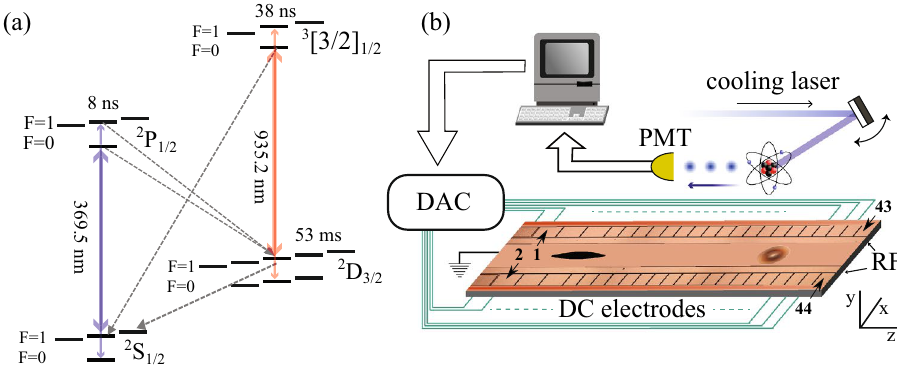
Figure 1. ( a ) Transitions for laser cooling 171 Yb + . The ion is laser cooled on the nearly closed 369.5 nm 2 S 1 / 2 , F = 1 to 2 P 1 / 2 , F = 0 transition. The small amount of off-resonant scattering into the 2 S 1 / 2 F = 0 state is repumped with a 14.7 GHz sideband on the primary cooling laser. Decays from 2 P 1 / 2 can also populate the 2 D 3 / 2 level, which are repumped using a 935 nm laser. ( b ) Schematics of the ion trap chip and the optimization devices. RF and DC electrodes are used to trap the ion and shuttle it above the diffracting mirror that collects photons from the ion and sends it to photo multiplayer tube (PMT). The PMT counts are processed by the optimiser and DC electrode voltages and cooling laser position are updated using a digital to analogue converter (DAC).